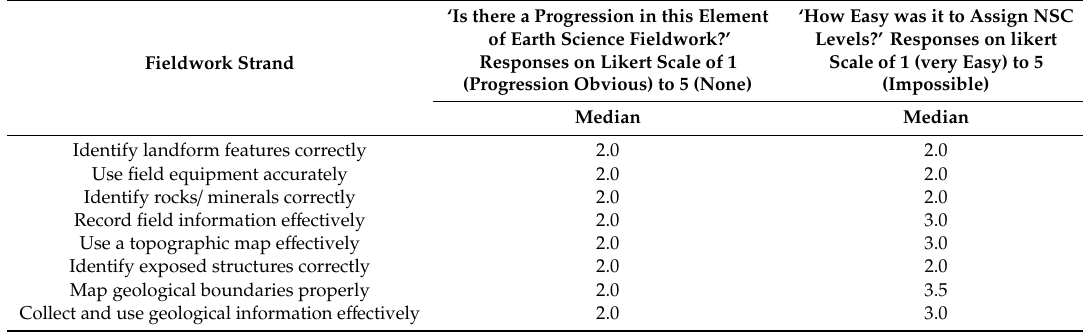
Table 4. Summary of feedback on the questions ‘Is there a progression in this element of Earth science fieldwork?’ and ‘How easy was it to assign National Curriculum for Science (NCS) levels?’ for each strand.